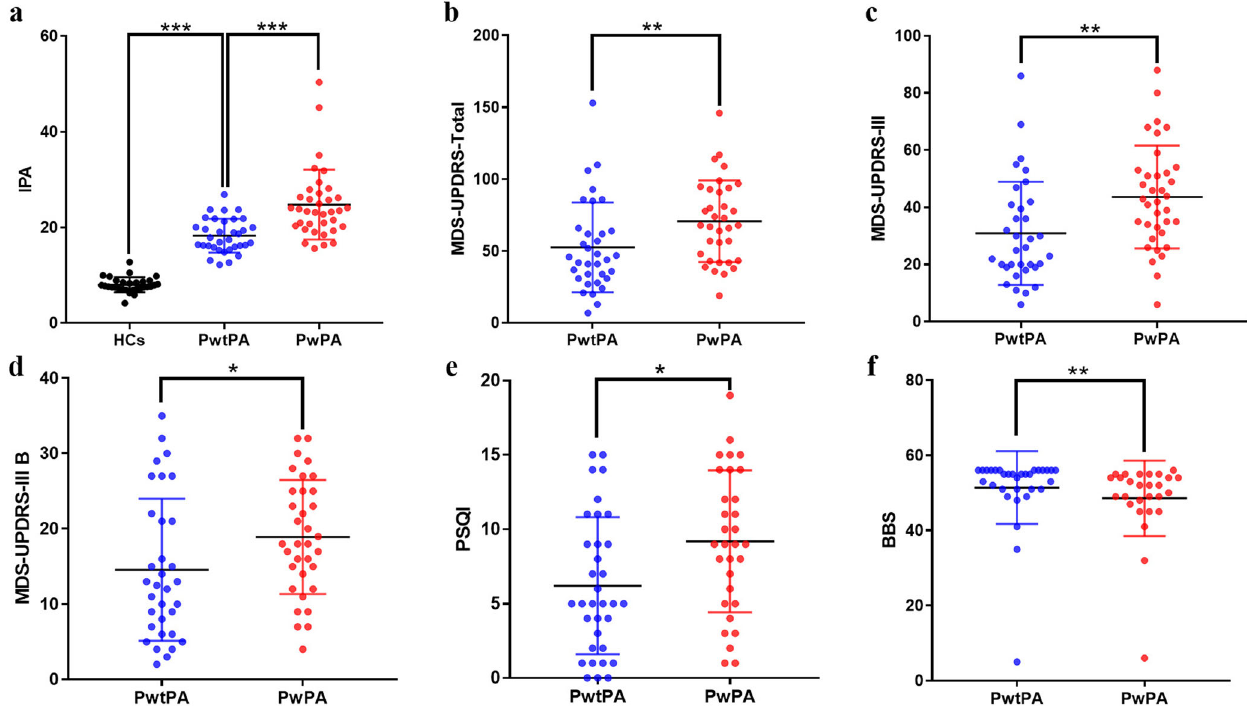
Fig. 2 Clinical characteristics of the participants. Comparisons of IPA between PD and HCs ( a ) and comparisons of MDS-UPDRS-Total, MDS- UPDRS-III, MDS-UPDRS-III B, PSQI and BBS characteristics between groups of PwtPA and PwPA ( b – f ). Data are mean with error bars representing standard deviation. * p < 0.05, ** p < 0.01, *** p < 0.001. PD Parkinson ’ s Disease, PwtPA PD without postural abnormalities, PwPA PD with postural abnormalities, HCs healthy controls, IPA the index for postural abnormalities, MDS-UPDRS the Movement Disorder Society- Sponsored Revision of the Uni fi ed Parkinson ’ s Disease Rating Scale, PSQI the Pittsburgh Sleep Quality Index, BBS the Berg Balance